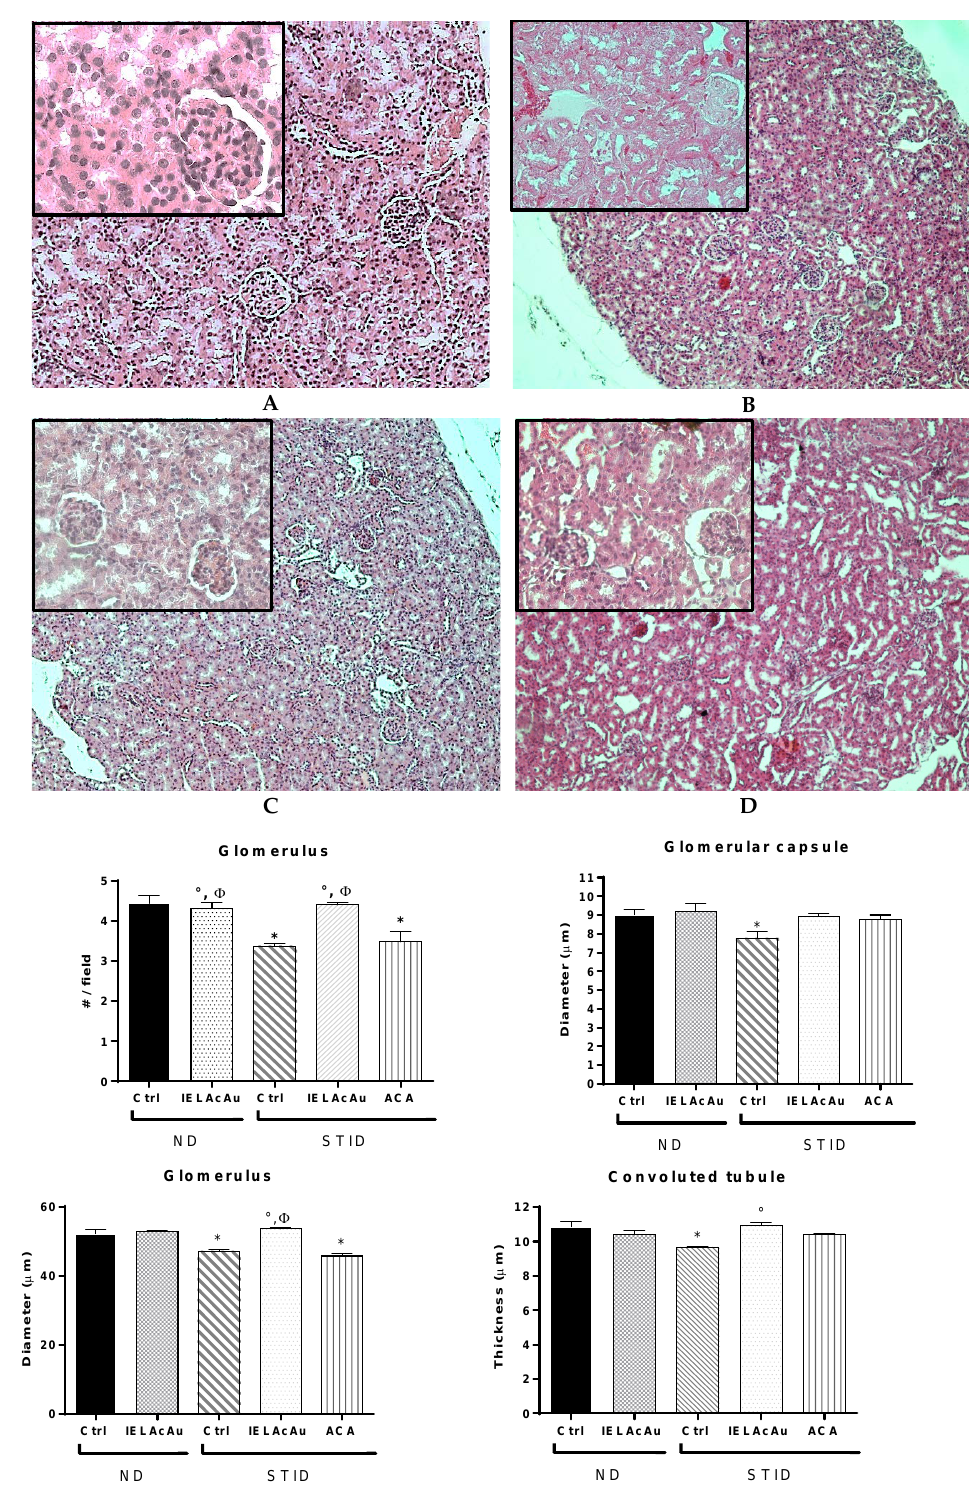
Figure 4. ( Top ) Representative photomicrographs with H&E staining of transversal kidney sections after the administration of IELAcAu in non-diabetic (ND) and streptozocin-induced diabetic (STID) mice. ( A ) ND control. ( B ) STID control. ( C ) STID with IELAcAu (300 mg/kg bw). ( D ) STID with Acarbose (ACA) (50 mg/Kg bw) (magnification 10× and box 40×). ( Bottom ) Quantitative analysis of glomerulus and convoluted tubules of kidney sections. Results are expressed as the mean ± SEM, n = at least 9 fields in each group. * p < 0.05 vs. ND control; ° p < 0.05 vs. STID control; Φ p < 0.05 vs. acarbose.